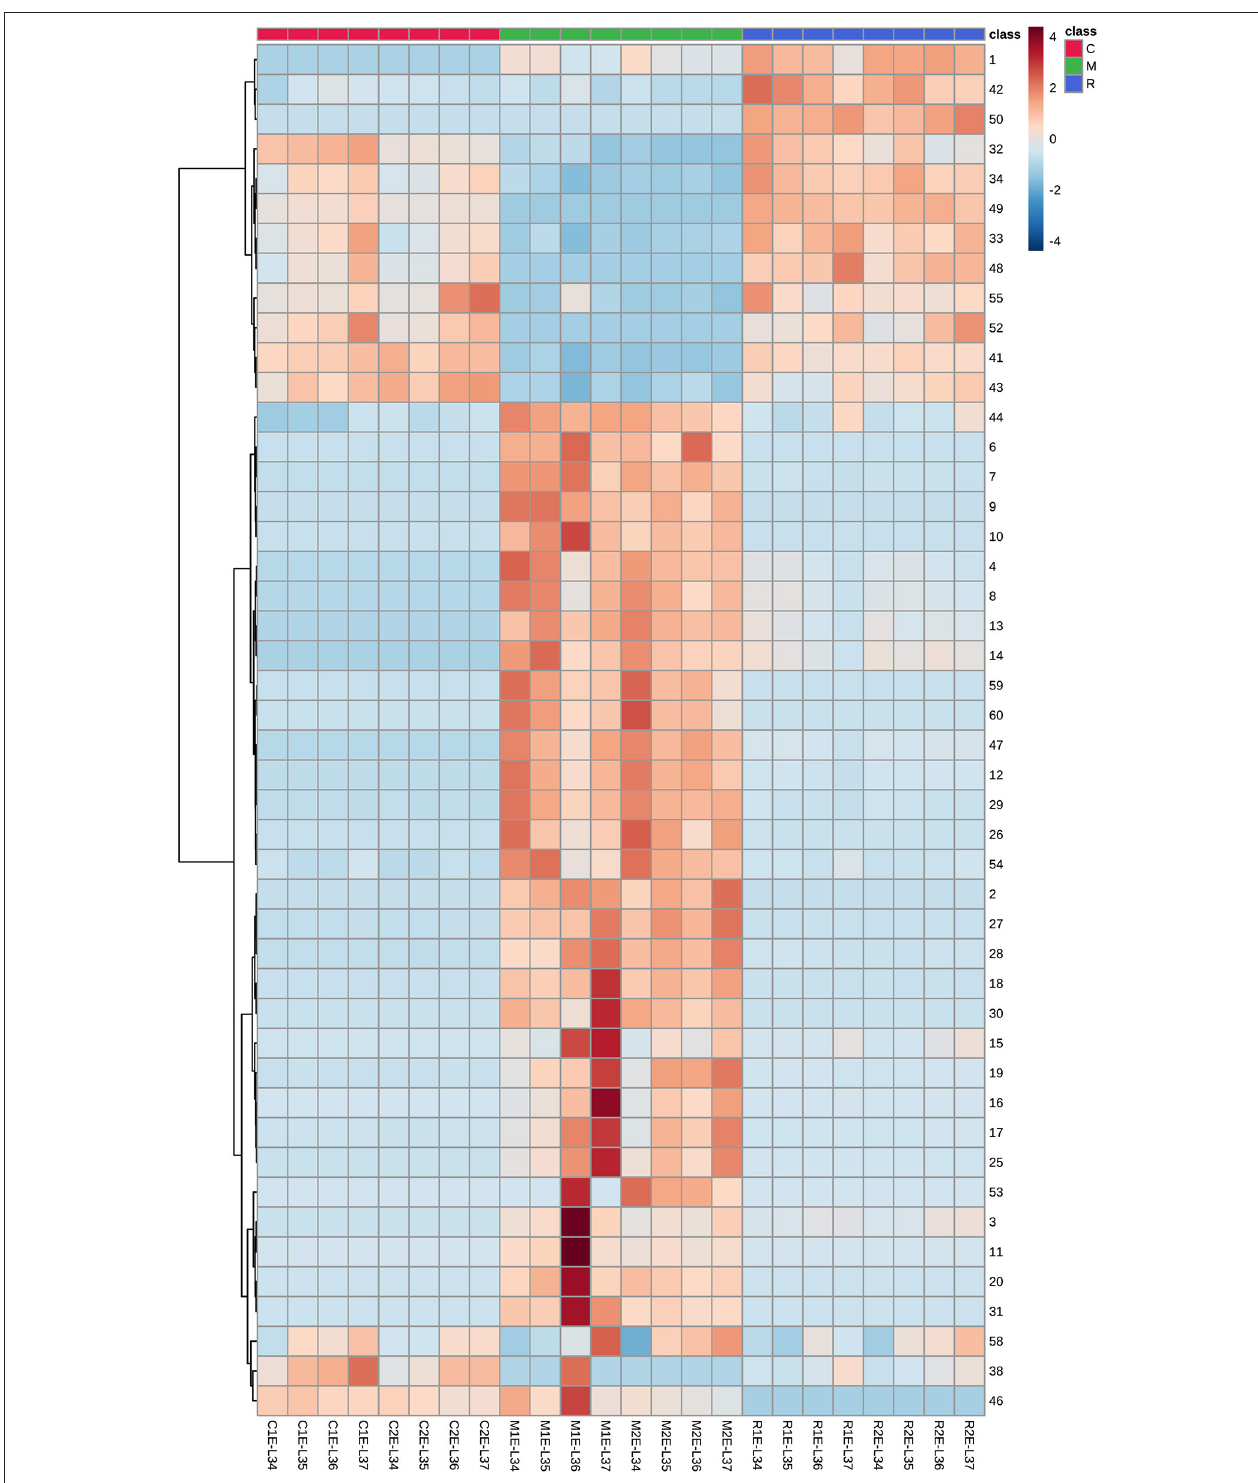
FIGURE 6 | Heatmap of the transformed data for various glycosidic aroma compounds in three grape varieties at four ripening stages. The marks below refer to the statement shown in Figure 3 . The numbers on the right correspond to compounds mentioned in Table 1 , Supplementary Tables 2 , 3 , Figures 1 , 5 .